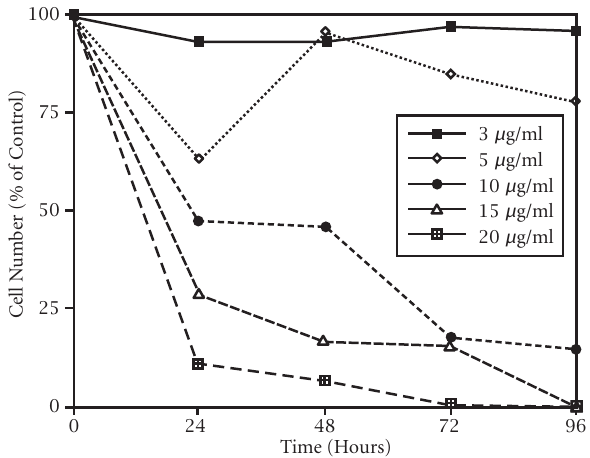
Figure 1: Growth inhibitory effect of tamoxifen on HeLa cells. Per- cent of control number of viable cells/ml as a function of time after tamoxifen treatment in 6 -well culture plates.